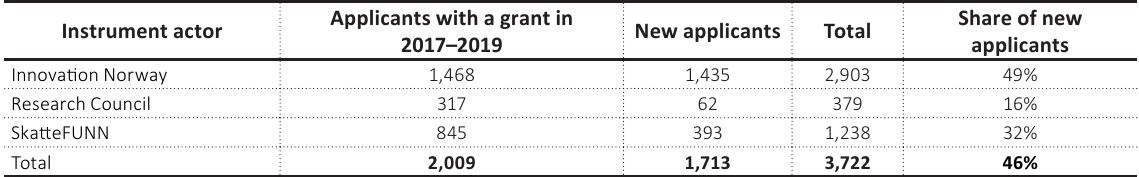
Table 1. Number of applicants with funding in 2020 by instrument